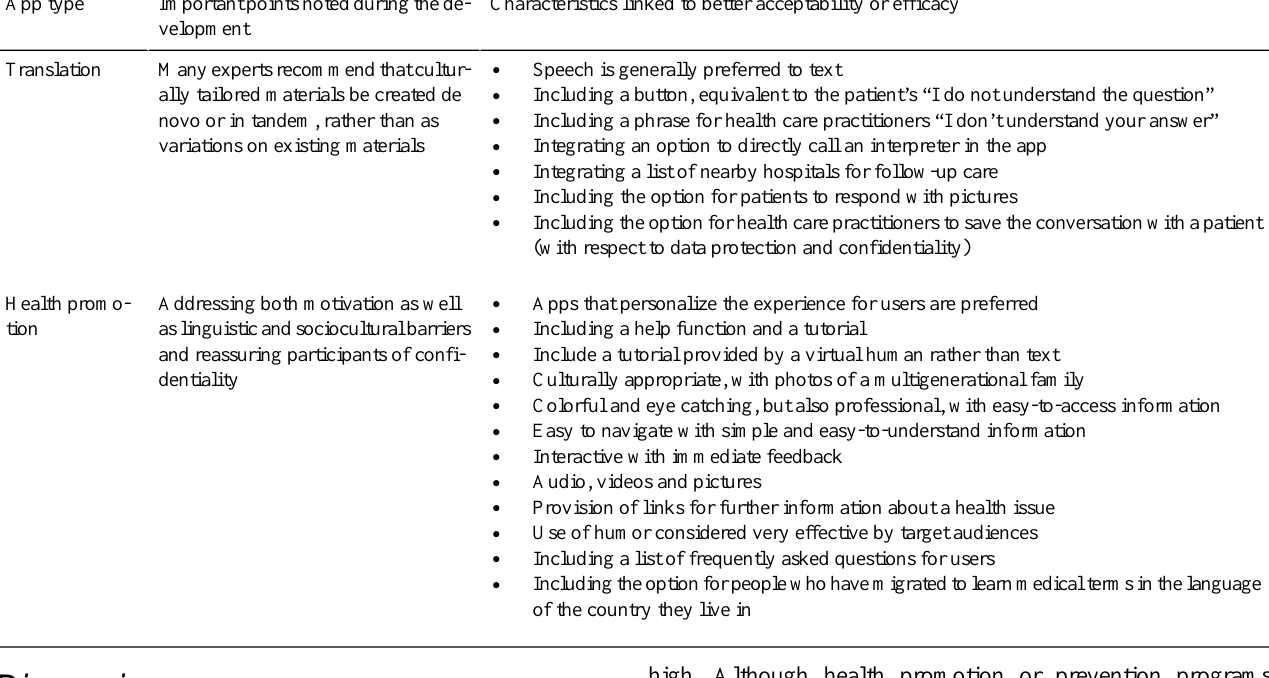
Table 3. Characteristics of health apps linked to better acceptability or